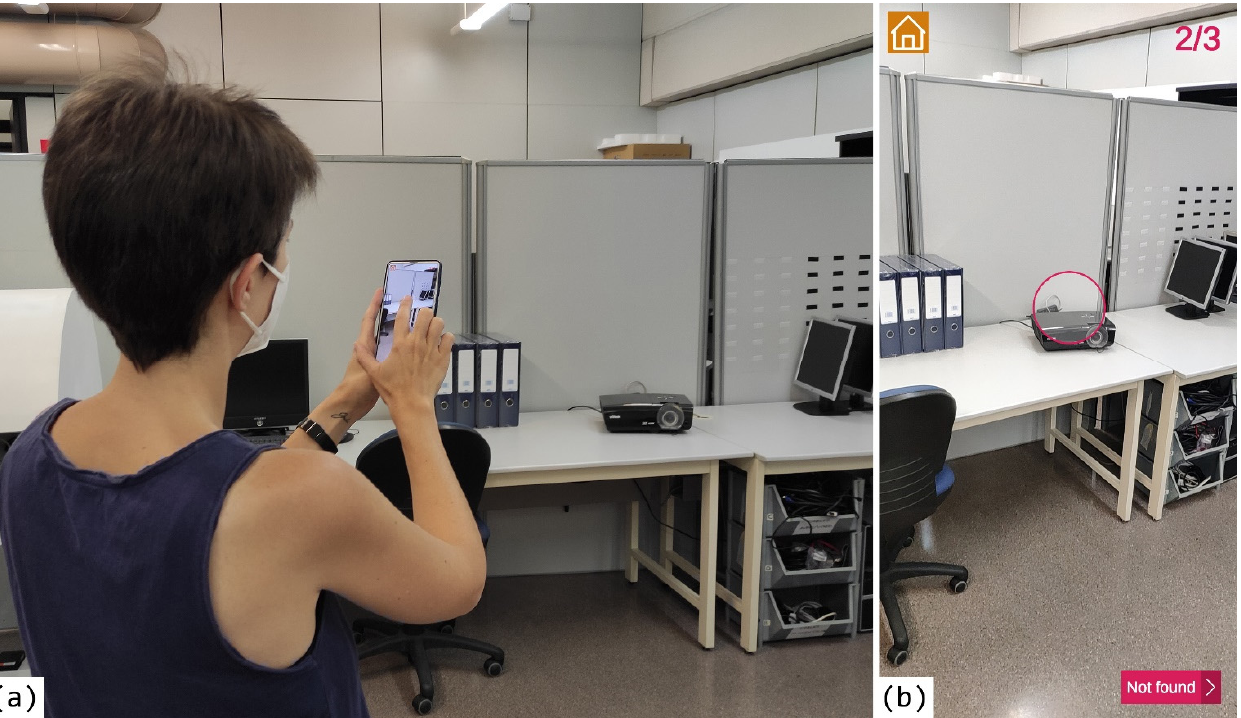
Figure 5. User testing the application ( a ) and screenshot of the application during the AR annotation search ( b ).